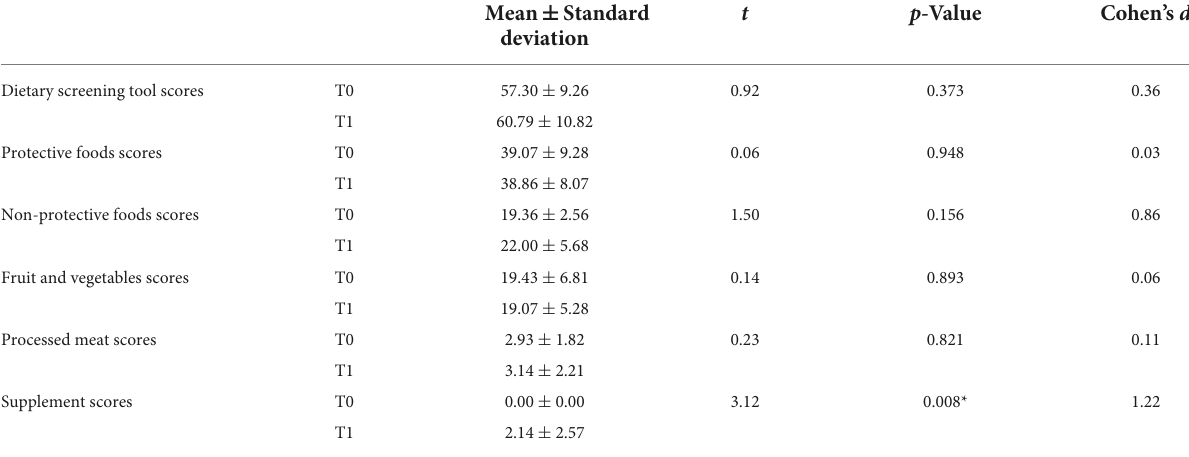
TABLE 2 Mean ± standard deviation of total Dietary Screening Tool and its parts scores of the participants ( n = 15) before (T0) and 6 months of physical distancing (T1).